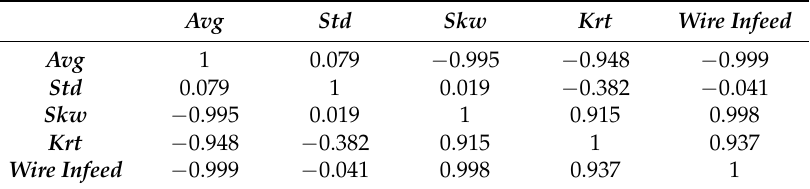
Table 4. Results from the correlation analysis ( PCC ) between wire infeed and features from T d distribution: average ( Avg ), standard deviation ( Std ), skewness ( Skw ) and kurtosis ( Krt ). Avg Std Skw Krt Wire Infeed